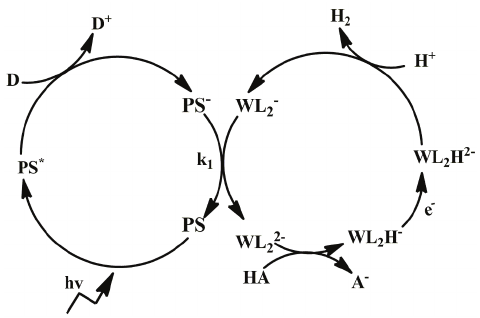
Figure 14: Emission spectra of [ReBr(CO) acetone, Inset: K as calculated from the Stern-Volmer plot and q τ =51 ns (25 o C ). re